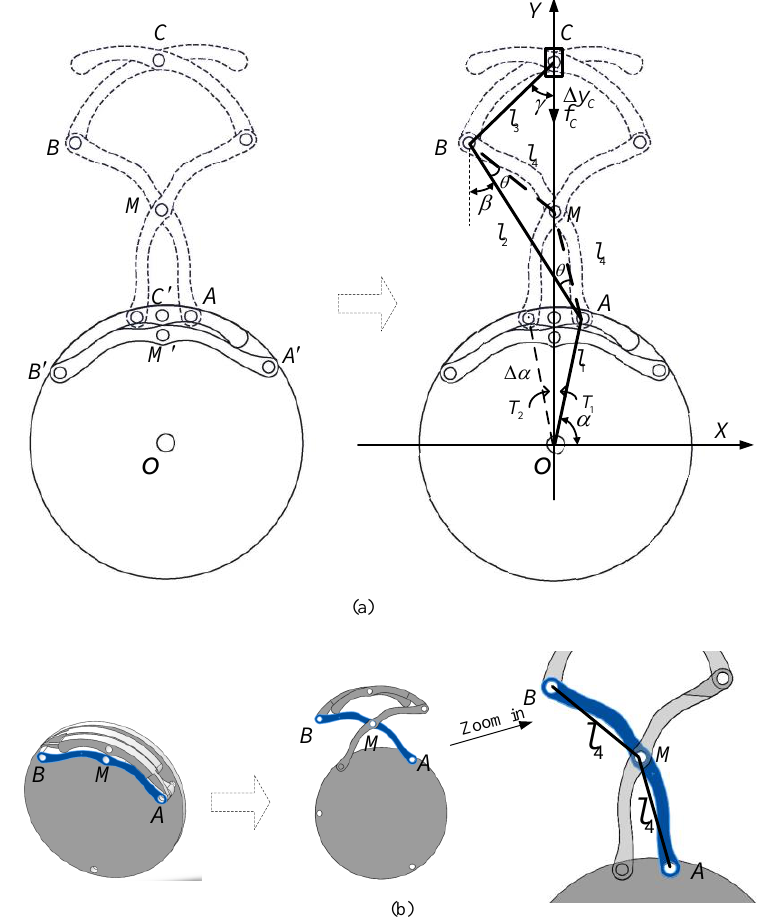
Figure 7. Kinematics and dynamics analysis of the expanding mechanism: ( a ) Equivalent slider crank mechanism; ( b ) the track screenshot of rod AB (mark in blue) during the expanding process.